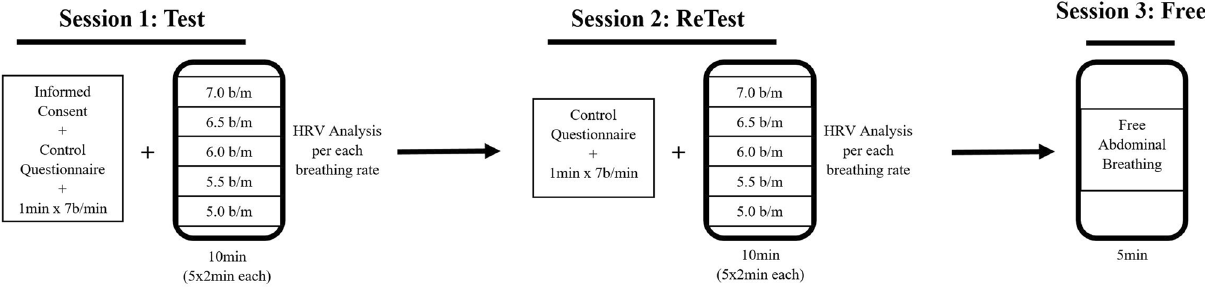
Figure 1. Schema of the study